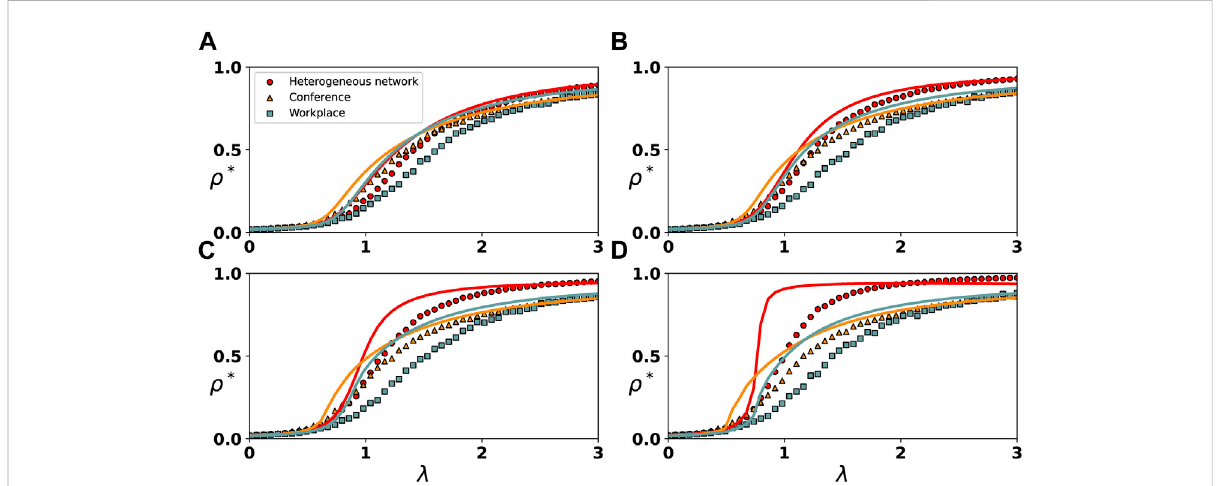
FIGURE 2 Evolutionofthe fi nalinfectiondensity ρ *with λ undervaryingratesof2-simplex.Thespreadoftheepidemicontheheterogeneousnetworkand two real-world networks are represented by circles, triangles and squares, respectively. For the spread on the heterogeneous network, we set λ * = 0.5in (A) , λ *=3.5in (B) , λ *=6.5in (C) and λ *=12in (D) .Forthespreadonthereal-world networks,weset λ *=0.5in (A) , λ *=1.5in (B) , λ *=2.5in (C) and λ * = 4.5 in (D)